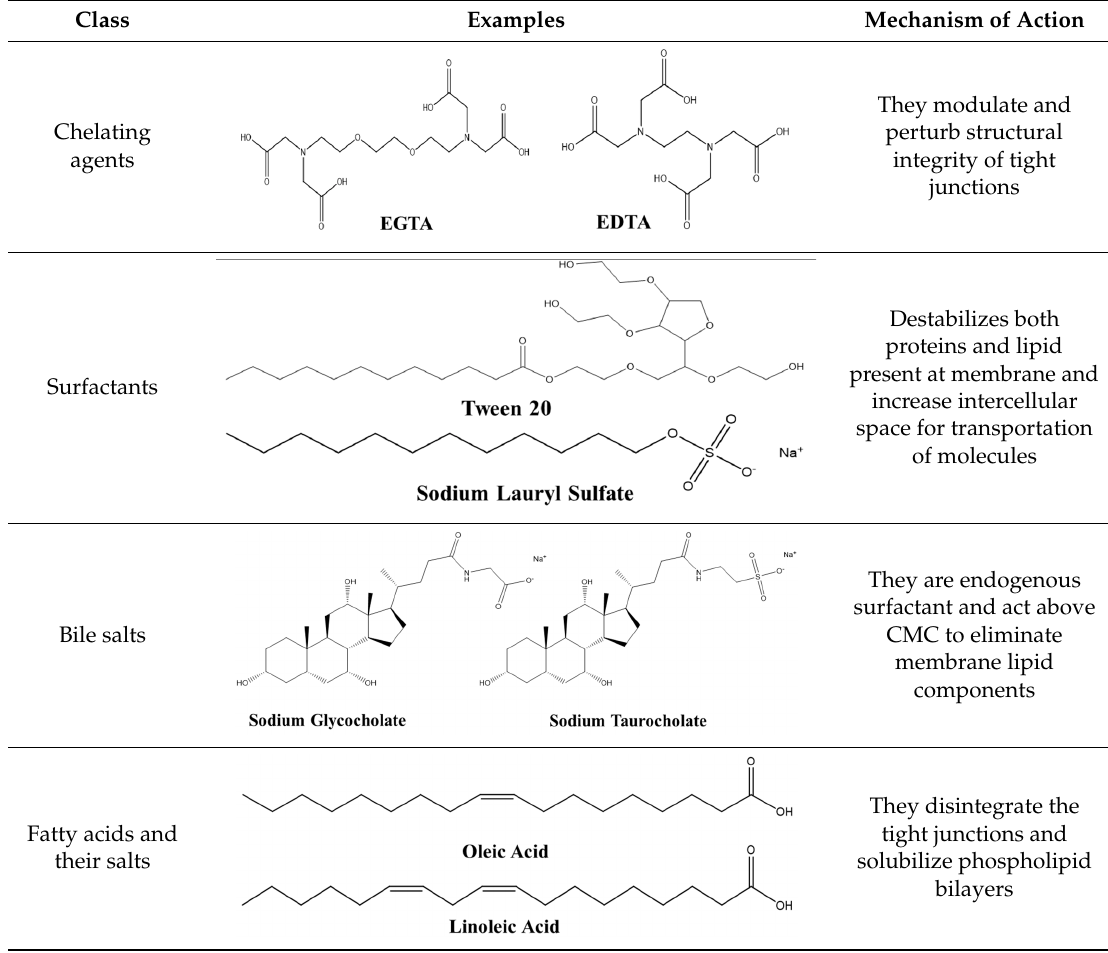
Table 2. Commonly used permeation enhancers for oral delivery of therapeutic peptides and proteins thrombotic thrombocytopenic purpura (TPPs).